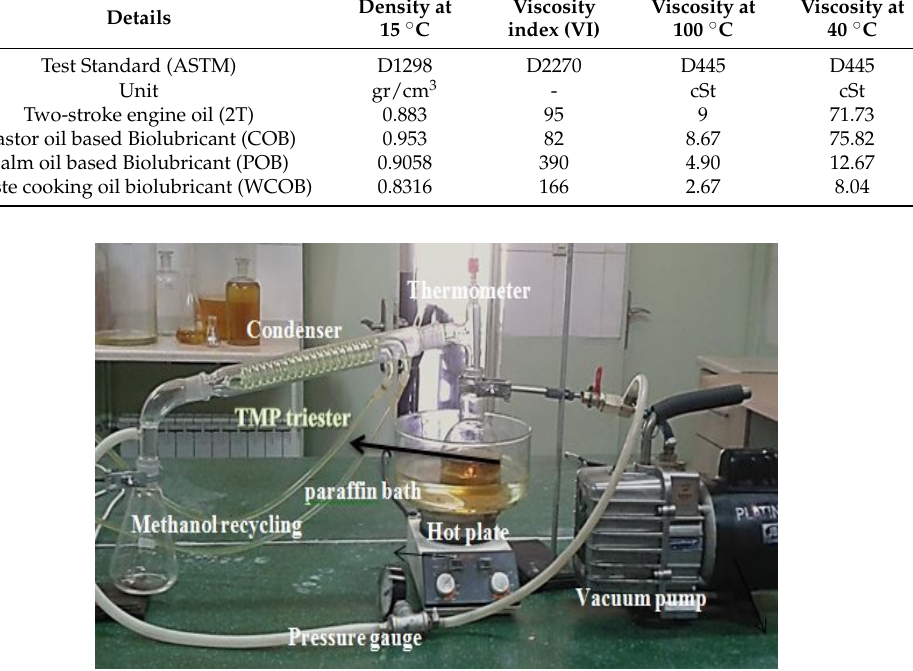
Figure 4. Biolubricant synthesis process by transesterification method.